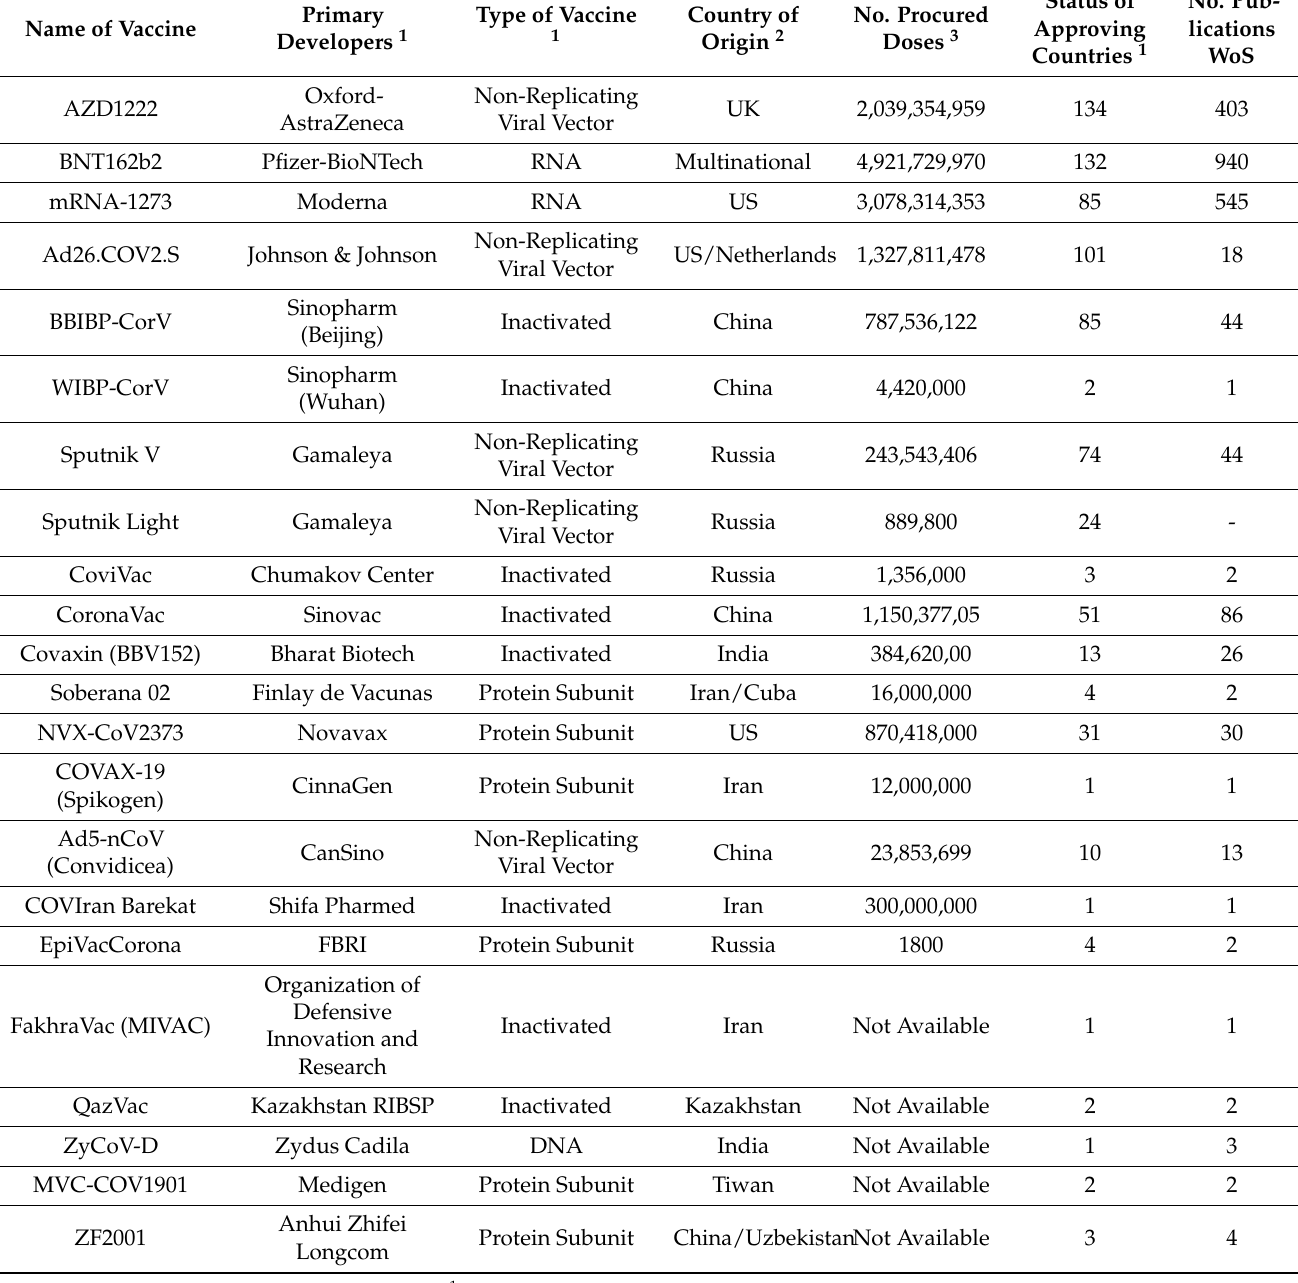
Table 7. Information on COVID-19 vaccines, type of vaccine, procured dose, approval satus, publica- tions in